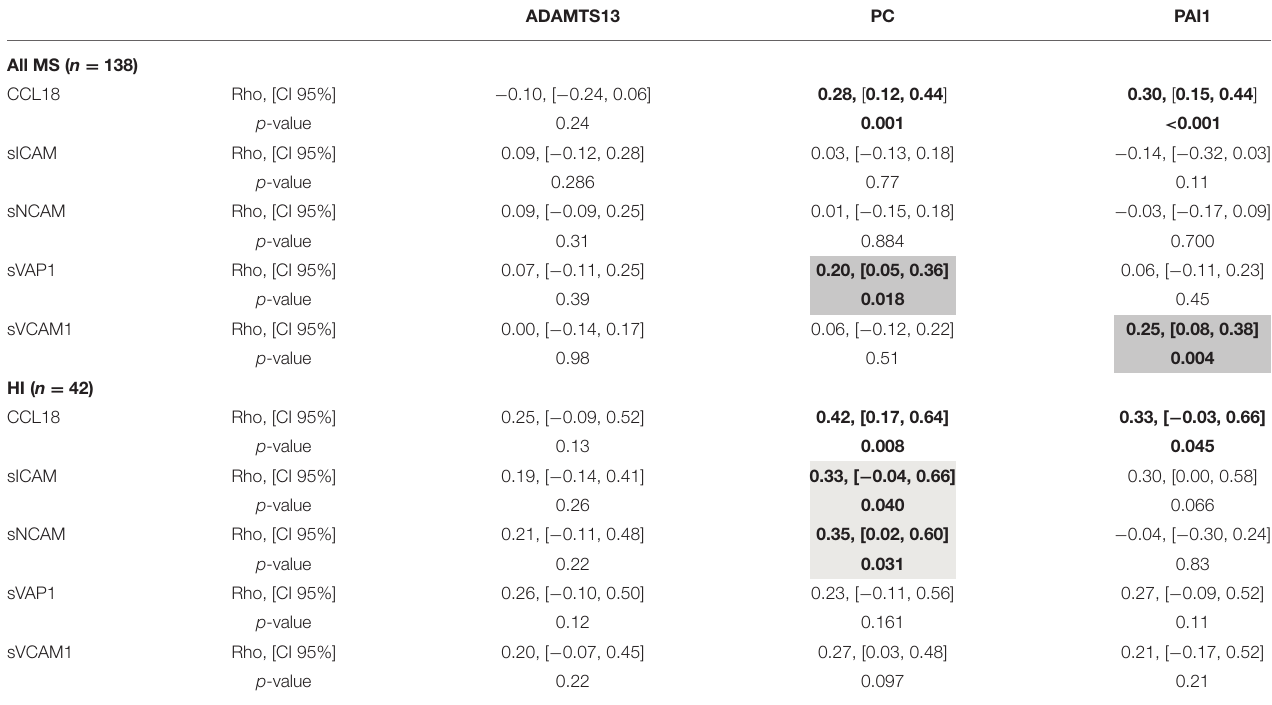
TABLE 4 | Correlations among protein levels in multiple sclerosis patients and healthy individuals.